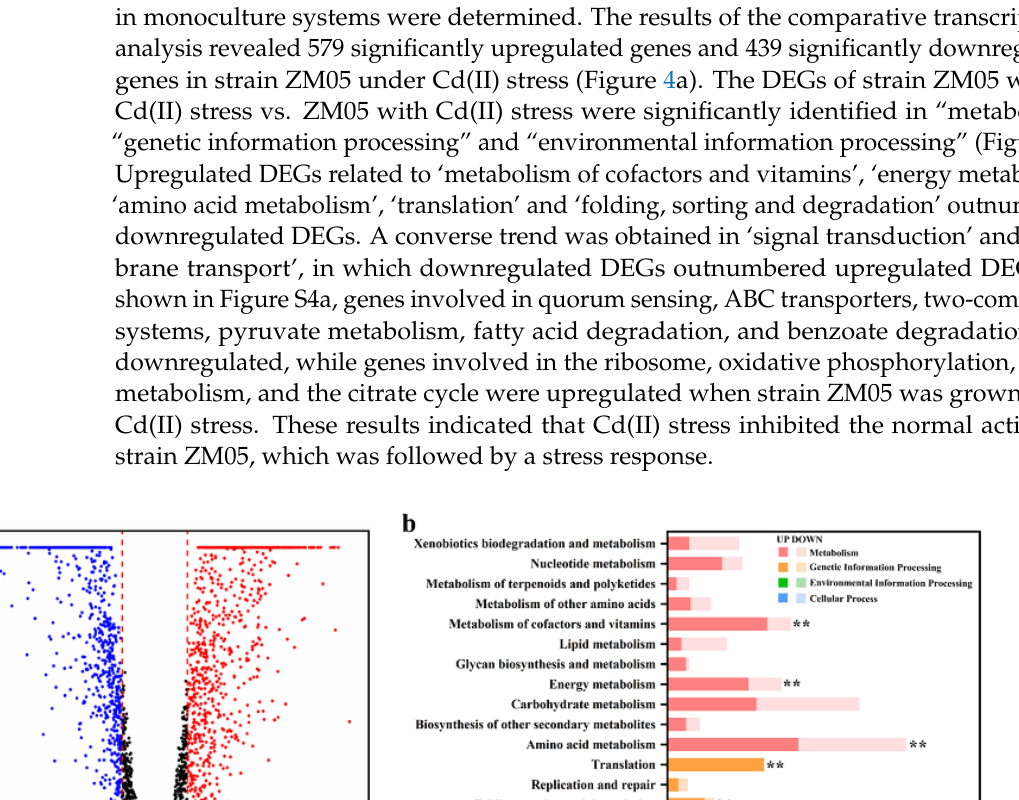
Figure 5. Volcano plot ( a ) and KEGG enrichment analysis ( b ) of DEGs from strain ZM05 in the monoculture system or coculture system under Cd(II) stress. ** p < 0.01.